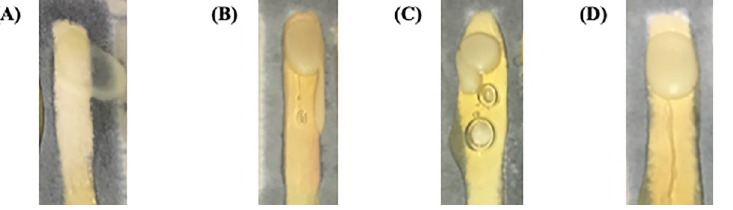
Fig 3. μ PAD growth score guide. The Growth Scores quantified the characteristic growth fronts within channels that would influence final growth displacement measurements. (A) Score 0 indicates agar or inoculum spillage from the hydrophobic barriers, rendering data points of one or more channels useless. (B) Score 1 indicates “side growth” where only < 25% of the colony front would grow farther than the rest of the colony along the hydrophobic barrier, making it difficult to determine a point of reference for growth. (C) Score 2 indicates “irregular growth fronts” where an obstruction (air bubble) or accidental inoculation error resulted in a heterogeneous front that does not completely span the width of the channel, making it difficult to determine a point of reference for growth. (D) Score 3 indicates “flat fronts” where the colony would completely span the width of the channel, and the colony front was perpendicular to the hydrophobic barrier. This growth pattern is